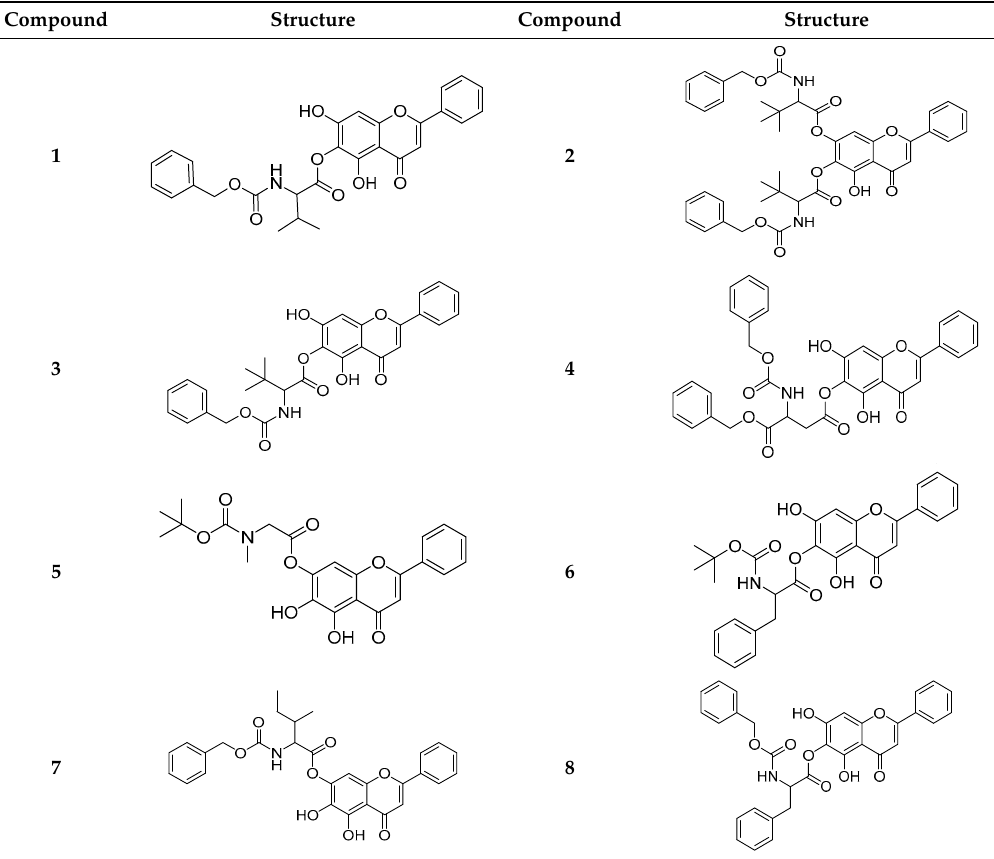
Table 1. The structures of baicalein derivatives 1 – 15 .